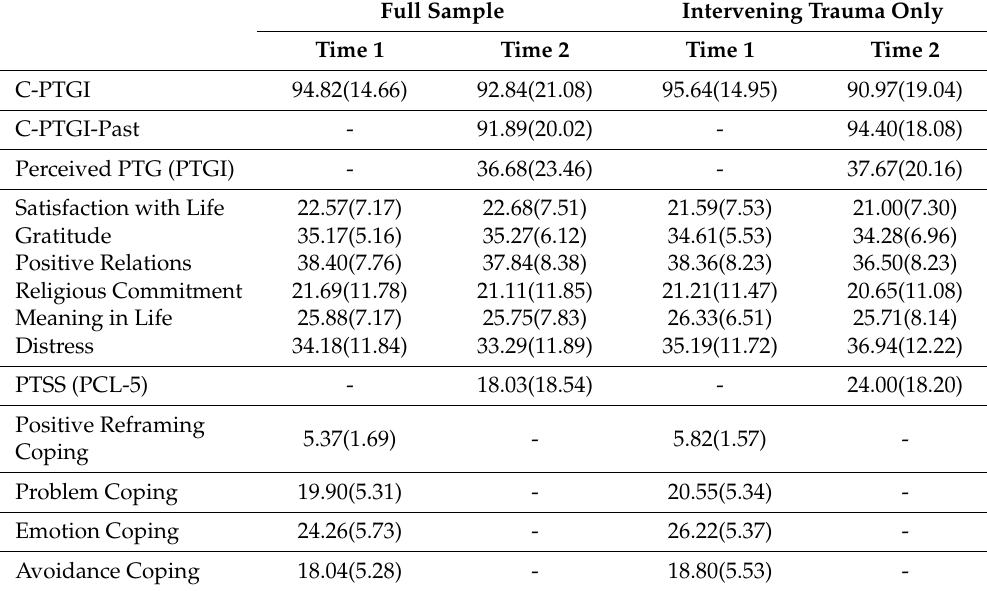
Table 2. Means and standard deviations of all variables.